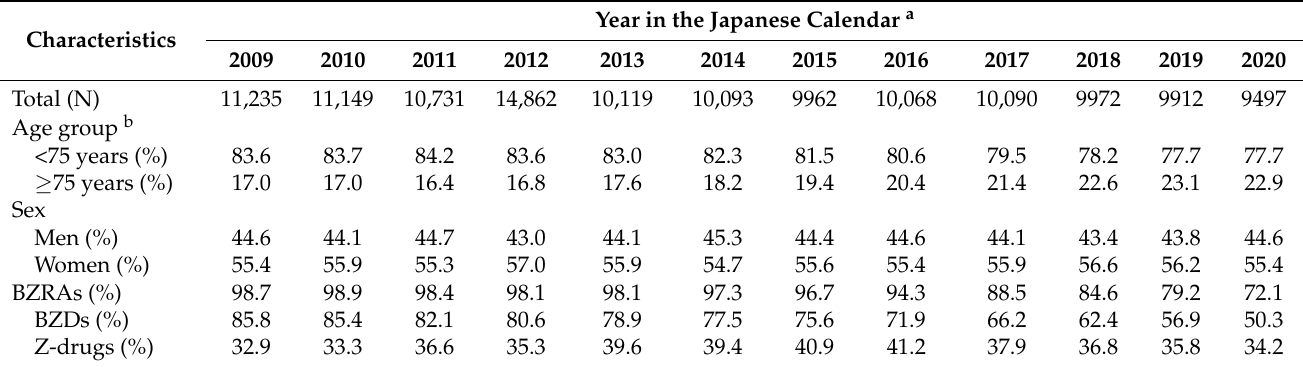
Table 1. Annual characteristics of the patients who were prescribed anxiolytics or hypnotics. Characteristics